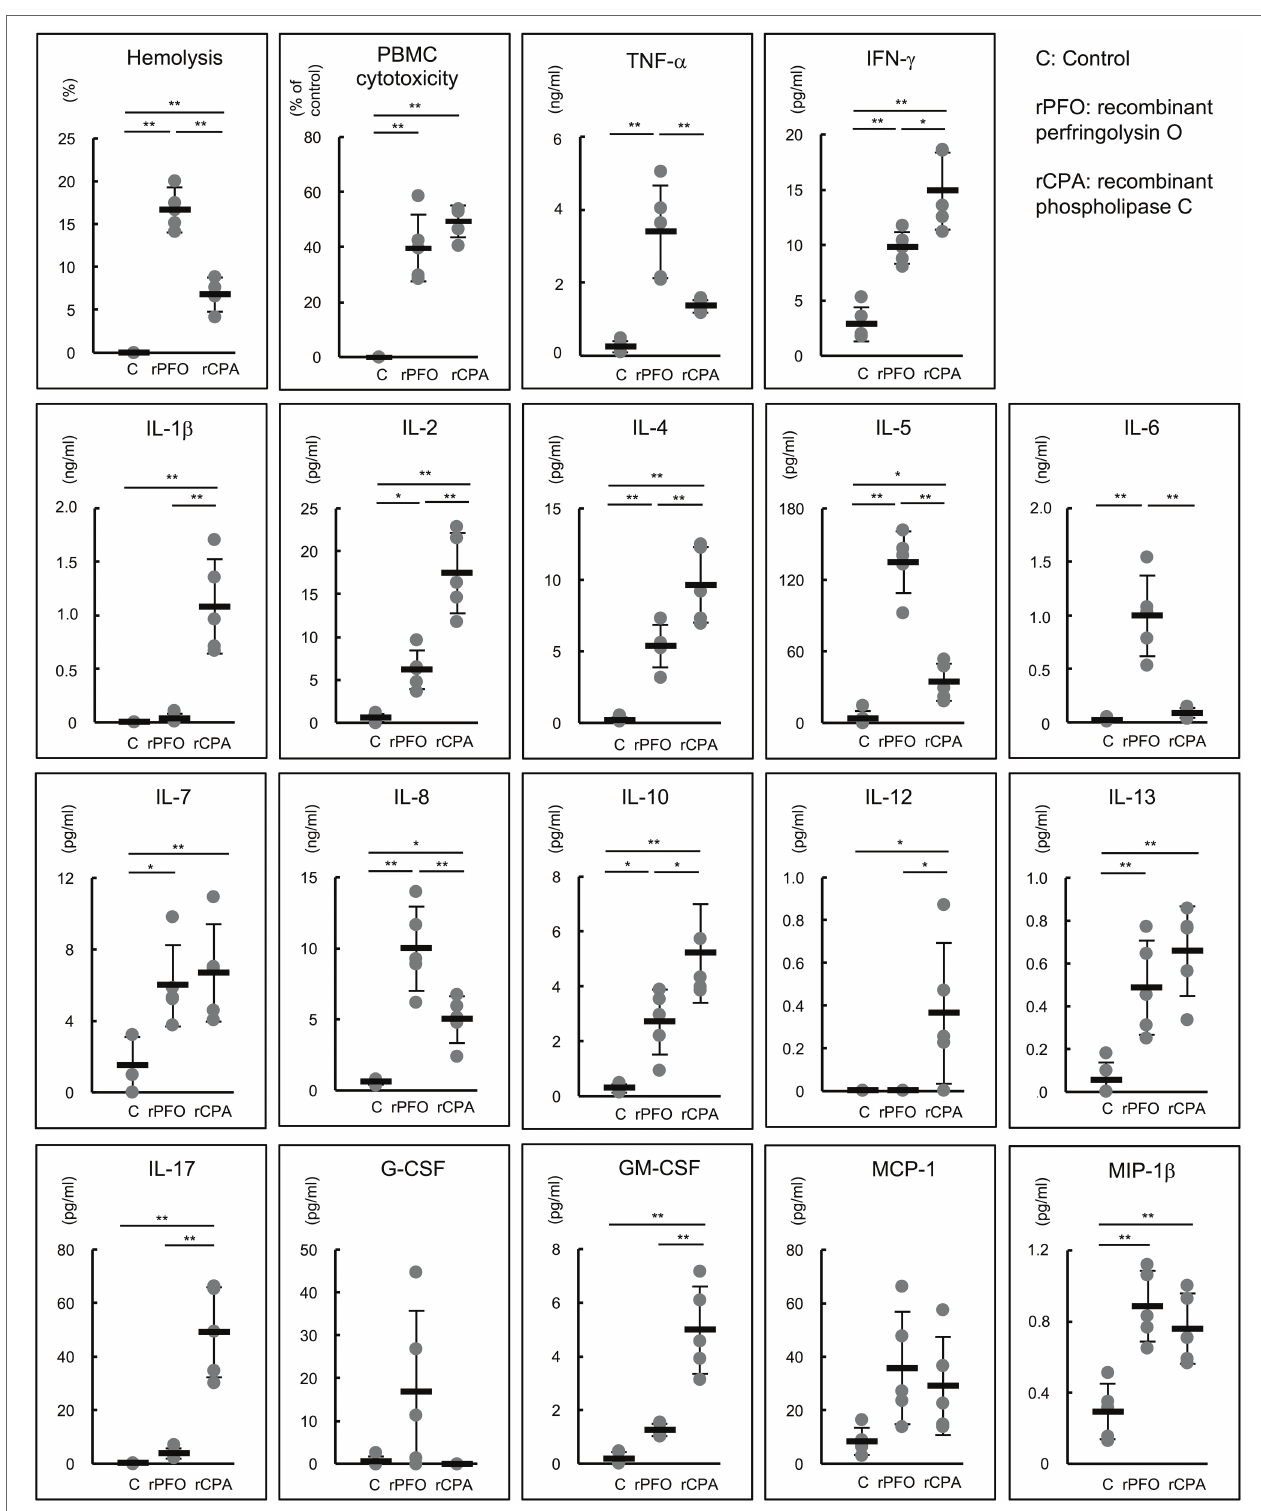
FIGURE 6 | Effects of rPFO and rCPA on human blood cells and the production of various cytokines. The effects of rPFO (63 ng/ml) and rCPA (0.016 U/ml) on human blood cells were evaluated using blood samples from five healthy volunteers. The same volume of phosphate buffered saline (PBS) was used as the control. The black bars indicate the average of five independent experiments conducted with technical duplicates, and the error bars indicate the SDs. ** p < 0.01 and * p <